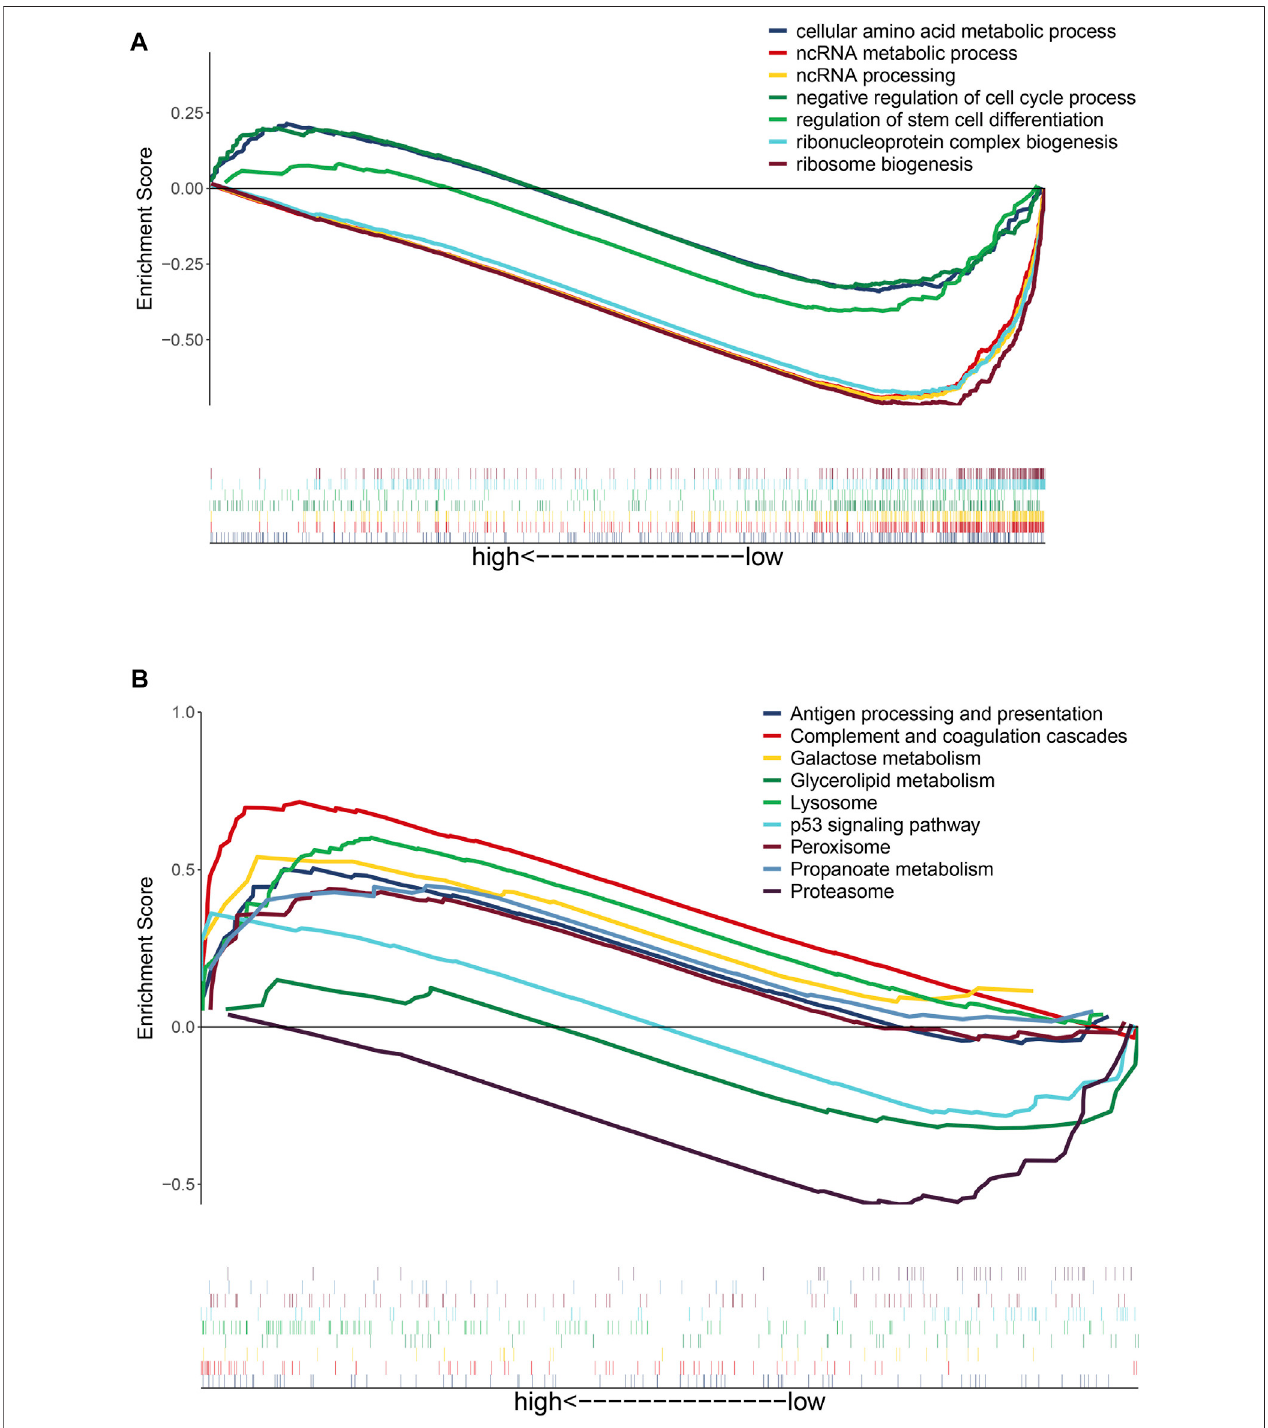
FIGURE 4 | Gene set enrichment analysis of differentially expressed genes potentially related to NSCLC resistance to EGFR-TKIs. (A) GO biological processes of candidate hallmarks. (B) KEGG pathways of candidate hallmarks.